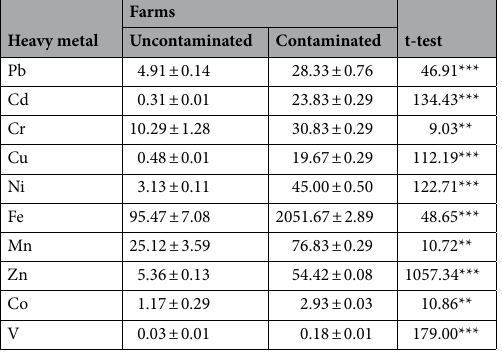
Table 5. Heavy metals concentration (Mean ± SD) in the edible fruits ( N = 18 ) of the eggplants cultivated in uncontaminated and contaminated farms. **: p < 0.01, ***: p < 0.001.